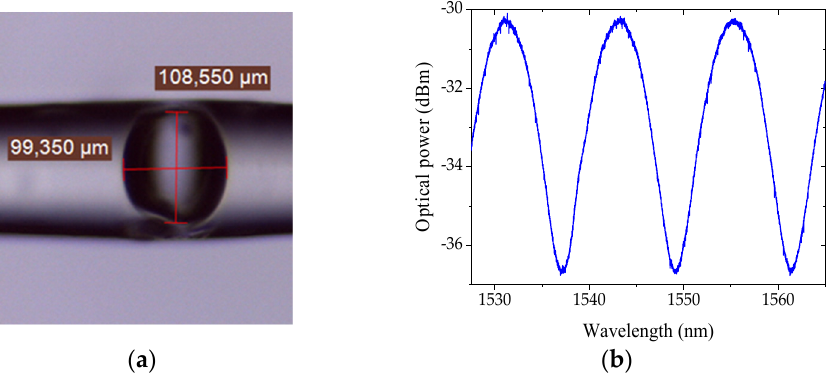
Figure 1. Resultant FPI: ( a ) microscopic image and respective dimensions; and ( b ) optical reflection spectrum.